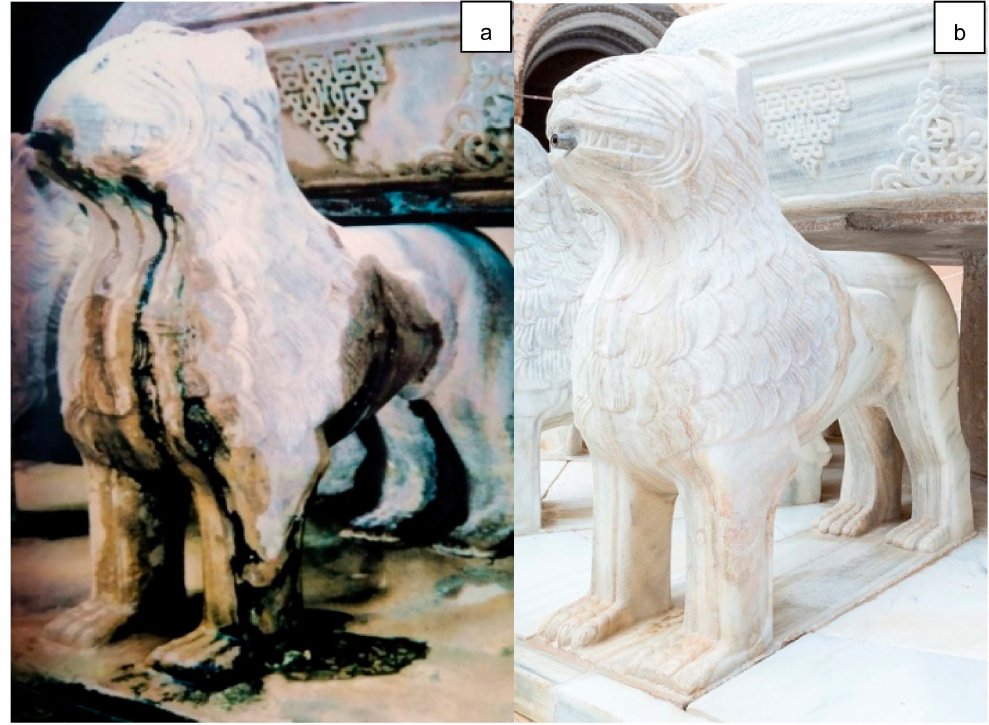
Figure 10. Presence of microalgae on one of the lions in the Fountain of the Lions: ( a ) an image from 1994 by F. Bolivar is shown on the left; ( b ) a modern image by G. Alfano in which one can see the e ff ect of the cleaning treatment and lack of large sheens on the surface is shown on the